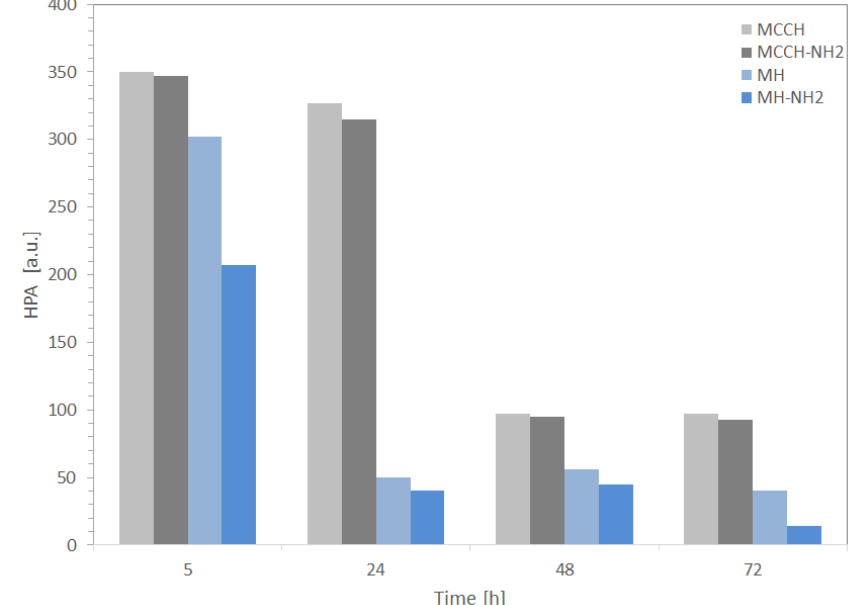
Fig. 8 Comparison of changes in hydroxyl peak area (HPA) during air-drying for MCC treated in water (MH) and water with ethylenediamine (MCCH-NH2, MH-NH